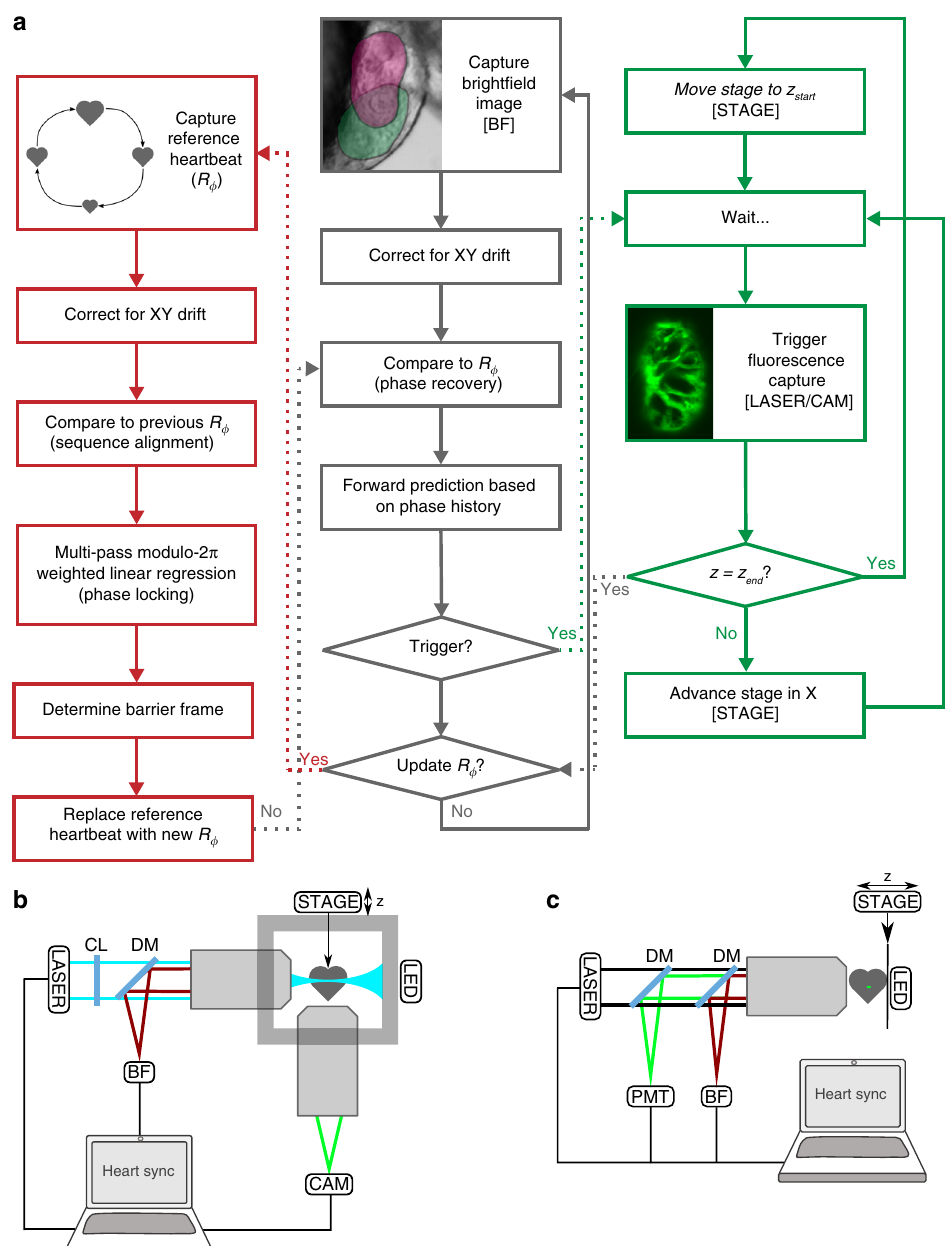
Fig. 2 Adaptive prospective optical gating permits day-long, phase-locked cardiac imaging. a Summary fl ow chart for adaptive prospective optical gating. Each column represents a separate thread running concurrently on the computer. The core prospective optical gating algorithm (centre, grey) identi fi es the current cardiac phase using the bright fi eld channel, and computes the correct future trigger time. The day-long phase locking algorithm (left, red) enables the system to cope with developmental-scale changes in cardiac morphology and size. The optical gating algorithms are integrated with fl uorescence z -stack acquisition and stage movement (right, green). Square brackets refer to hardware components in the schematic diagrams below. b , c Simpli fi ed schematics of the custom light sheet microscope ( b ) and commercial two-photon microscope ( c ) used in this paper, highlighting the key components for adaptive prospective optical gating. Fluorescence (excited by LASER) is imaged onto a triggerable scienti fi c camera (CAM) or photomultiplier (PMT). An infrared light source (LED) provides illumination for a bright fi eld camera (BF); in b this receives light collected through the laser launch objective, for reasons explained in the main text. A full optical diagram for b can be found in Supplementary Fig. 1. Other components: STAGE motorised z -stage; CL cylindrical lens; DM dichroic mirror to separate different light